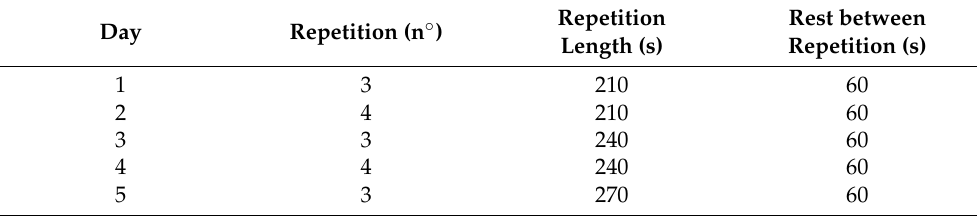
Table 3. Dosage of the virtual reality exercises for the second and third weeks of home treatment.